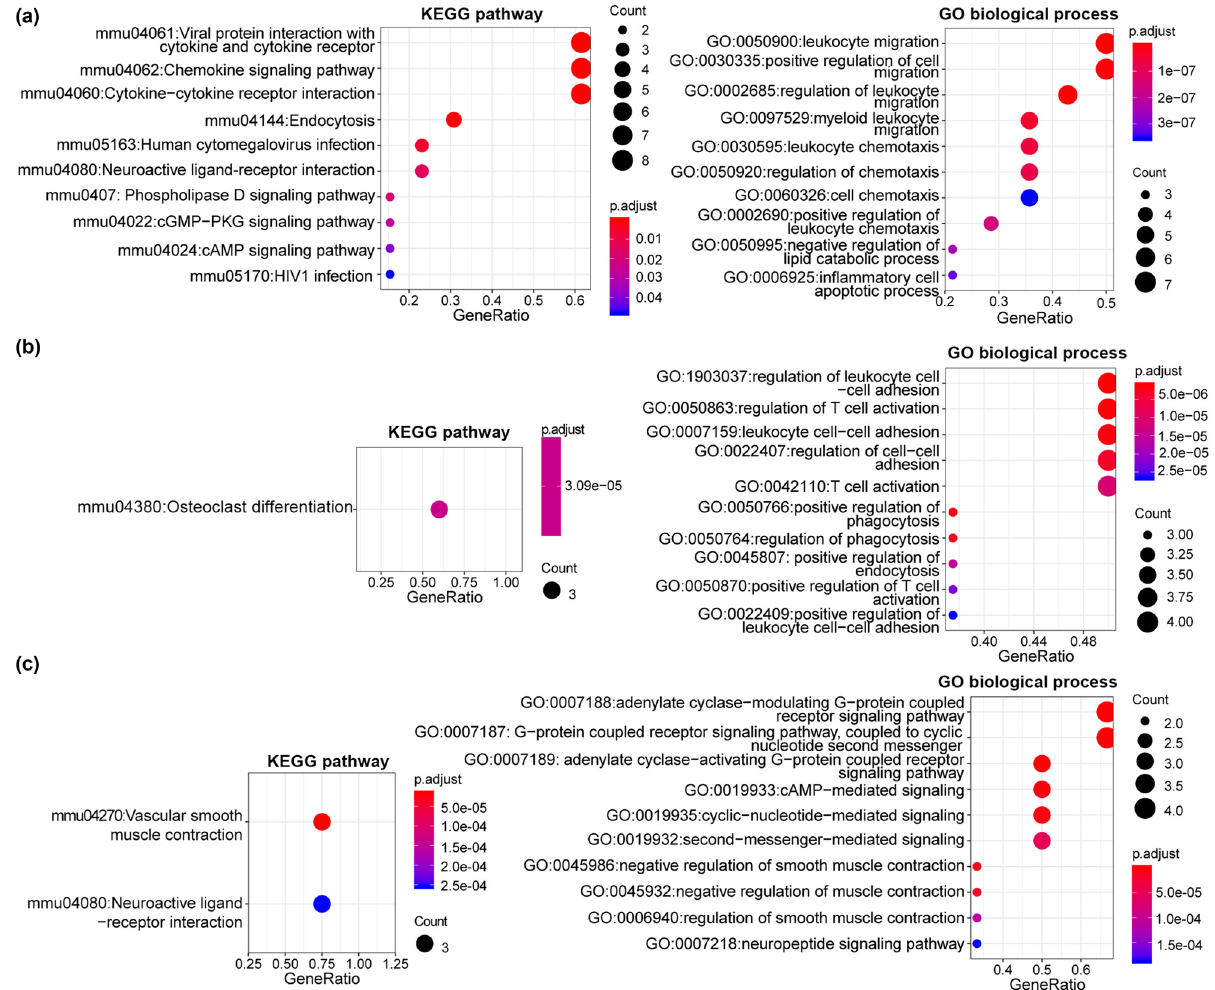
Figure 4: The enrichment of di ff erent expressed genes ( DEGs ) . ( a ) The top ten KEGG pathways and GO biological process terms of DEGs in module - A. ( b ) One KEGG pathway and top ten GO biological process terms of DEGs in module - B. ( c ) Two KEGG pathways and top ten GO biological process terms of DEGs in module -